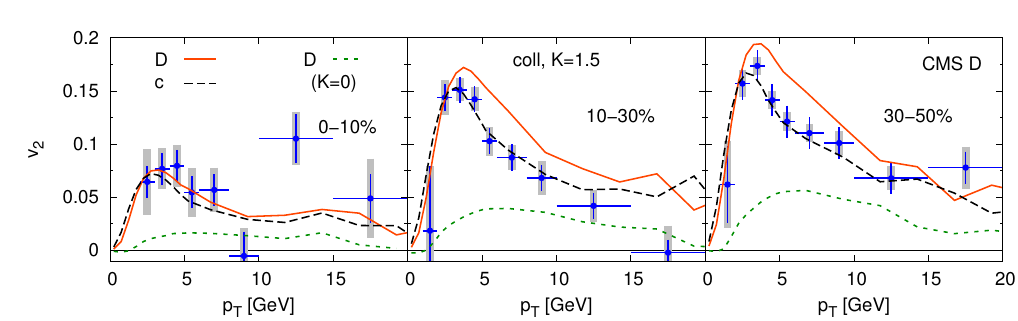
Figure 1. The centrality dependence of the elliptic flow of D mesons and charm quarks as a function of transverse momentum for a purely collisional energy loss scenario, scaled by K = 1 . 5. The solid (orange) curve is for final D mesons, the long dashed (black) curve is for charm quarks at the hadronization temperature of T c = 155 MeV and the short dashed (green) curve is a scenario without any in-medium interactions (corresponding to K = 0), where only coalescence contributes to the D meson flow. Experimental data is for D 0 mesons from the CMS collaboration [39].